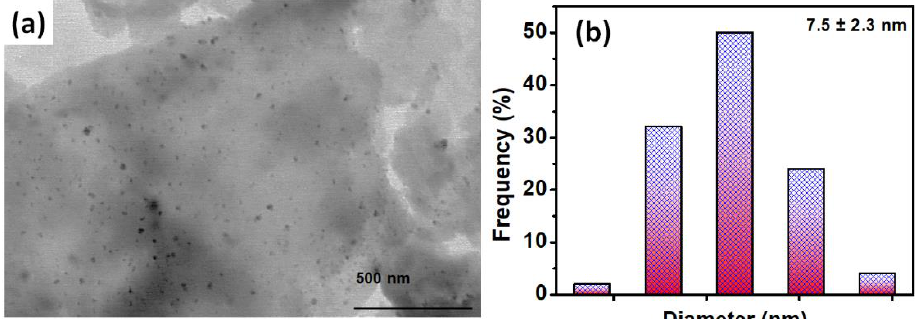
confirmed the thiol enrichment in HS-rGO 2% @g-C 3 N 4, .. According to XPS studies, the en-